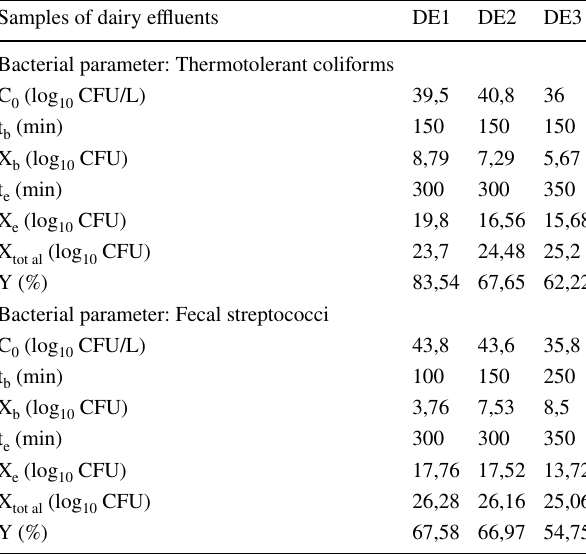
Table 6 Experimental results for thermotolerant coliforms and fecal streptococci removal by a local Kenadsa’s natural green clay, under continuous adsorption processes in a fixed-bed column Samples of dairy